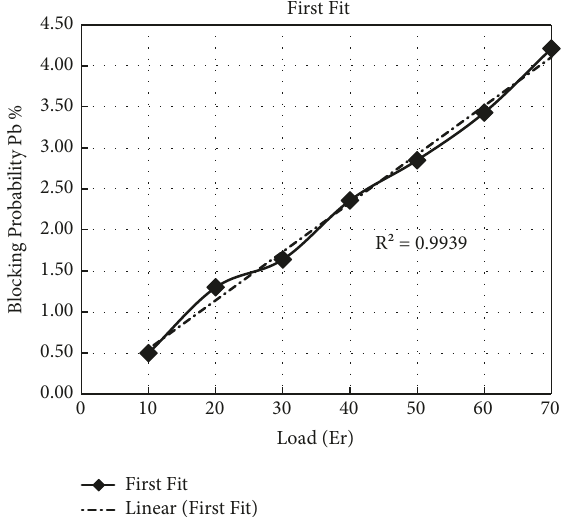
Figure 21: First Fit with BRP and Poisson arrivals.